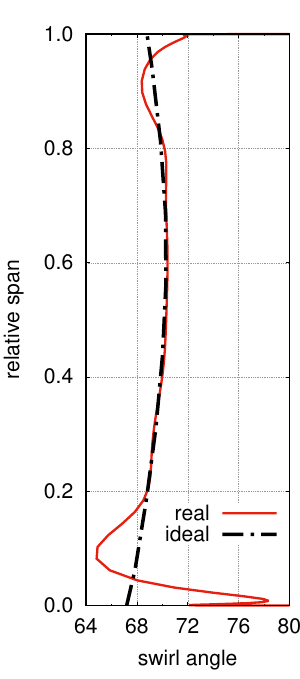
Figure 1. “Snaked” blade concept.